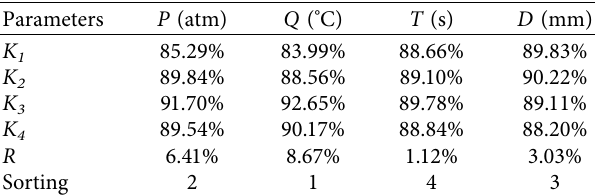
Table 4: Influence analysis of parameters on the